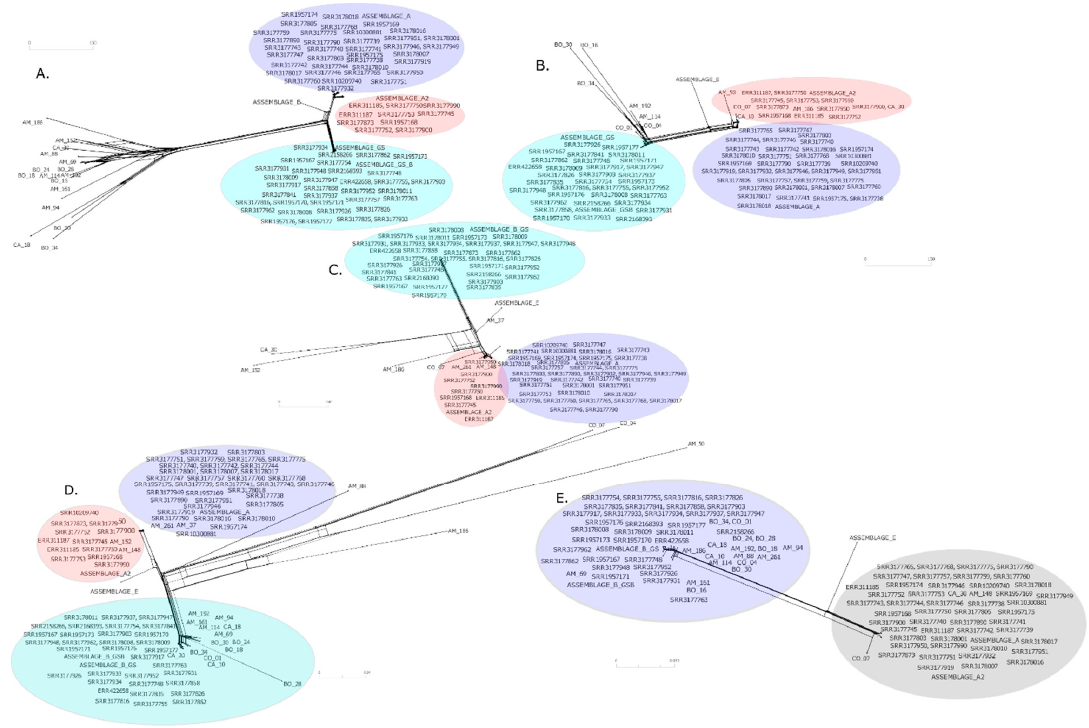
Figure 5. Phylogenetic network with SplitsTree [47] software, with sequences obtained from human faeces. ( A ) ACS . ( B ) Enolase . ( C ) SPT . ( D ) GDH . ( E ) TPI . Networks were built with the Neighbornet algorithm. Colours correspond to the assemblages (Blue: AI. Red: AII. Turquoise: B. Green: E. and ND: not defined). For the TPI gene, Assemblage A is highlighted in grey because AI and AII sub-